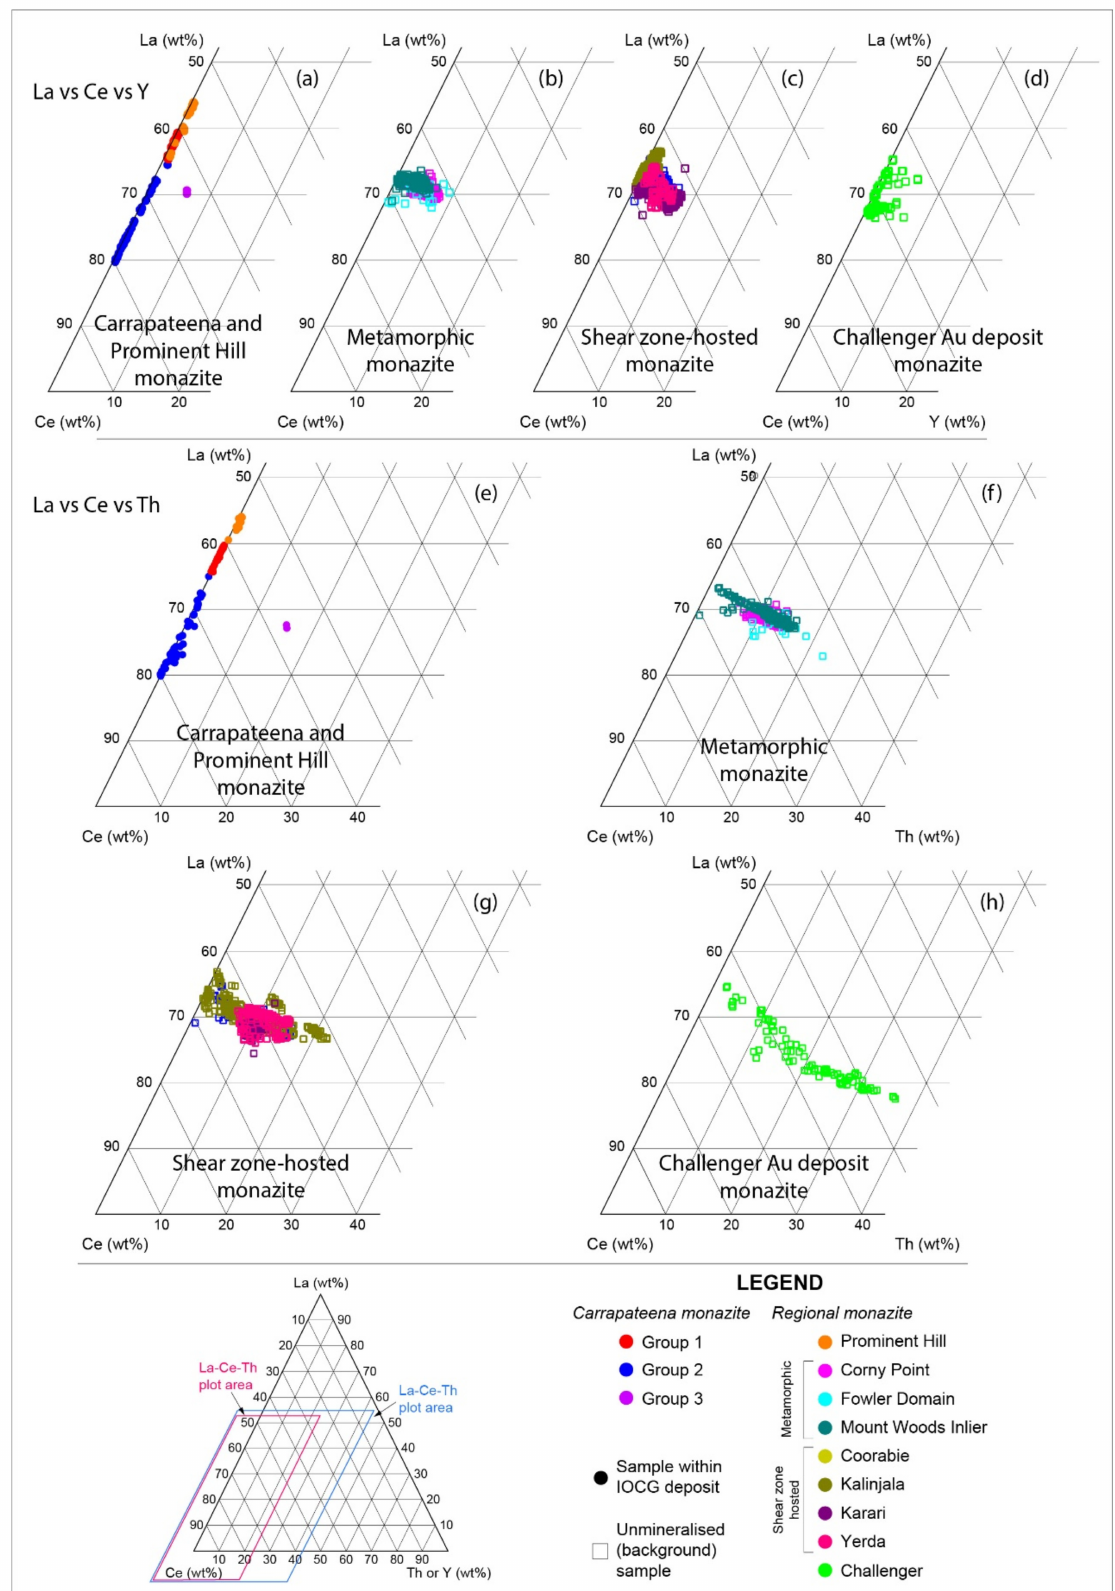
Figure 8. Ternary La vs. Ce vs. Y ( a – d ) and La vs. Ce vs. Th ( e , f ) diagrams for basement monazite from the Carrapateena and Prominent Hill deposits ( a , e ) and unmineralized basement including metamorphic monazite ( b , f ), shear zone-hosted monazite ( c , g ) and monazite from the Challenger Au deposit ( d , h